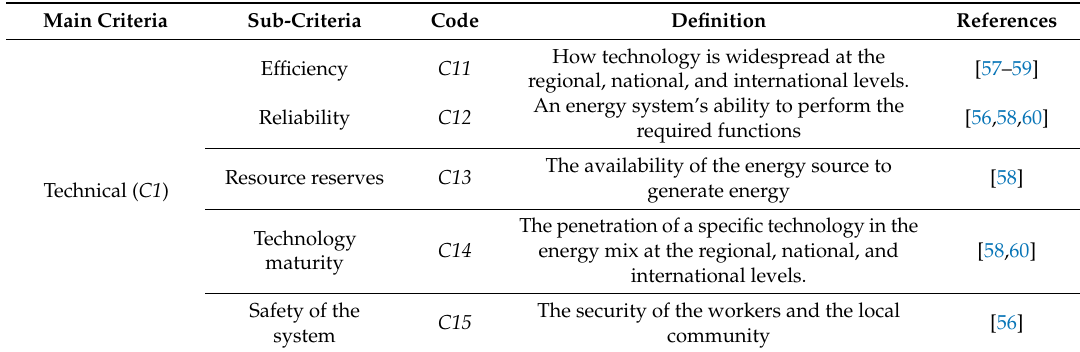
Figure 1. The local weights of the criteria according to the considered dimensions. Table 2. The criteria and sub-criteria used in this paper.